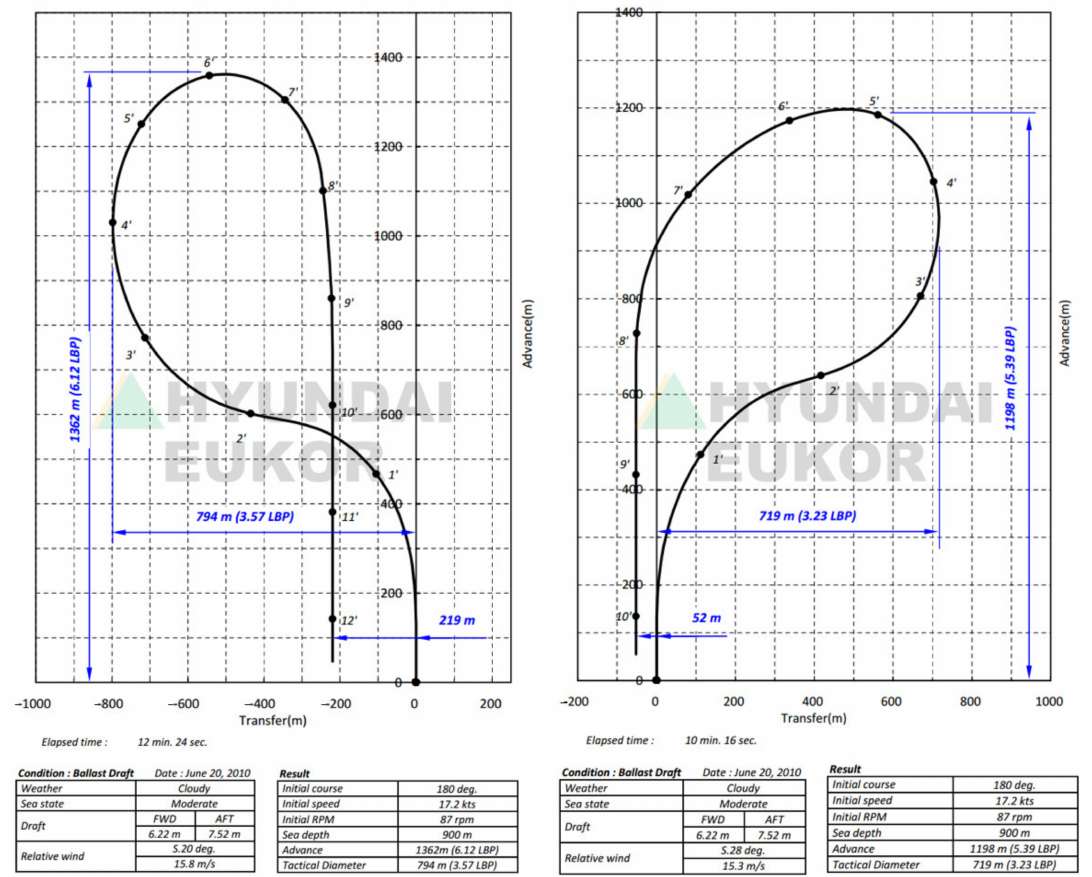
Figure 13. Williamson turning tests of M / V Morning